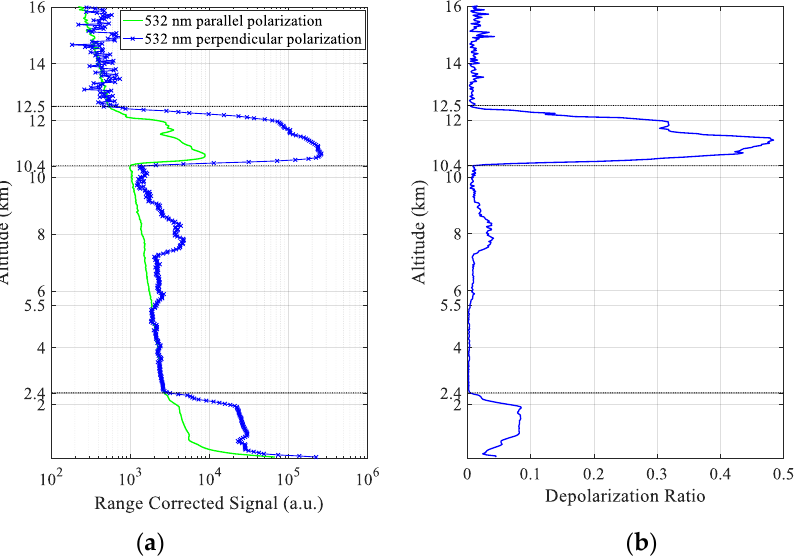
Figure 5. ( a ) The profiles of parallel polarization and perpendicular polarization channels’ RCSs at 22:20 on 6 July 2020; ( b ) The profile of DR at 22:20 on 6 July 2020.